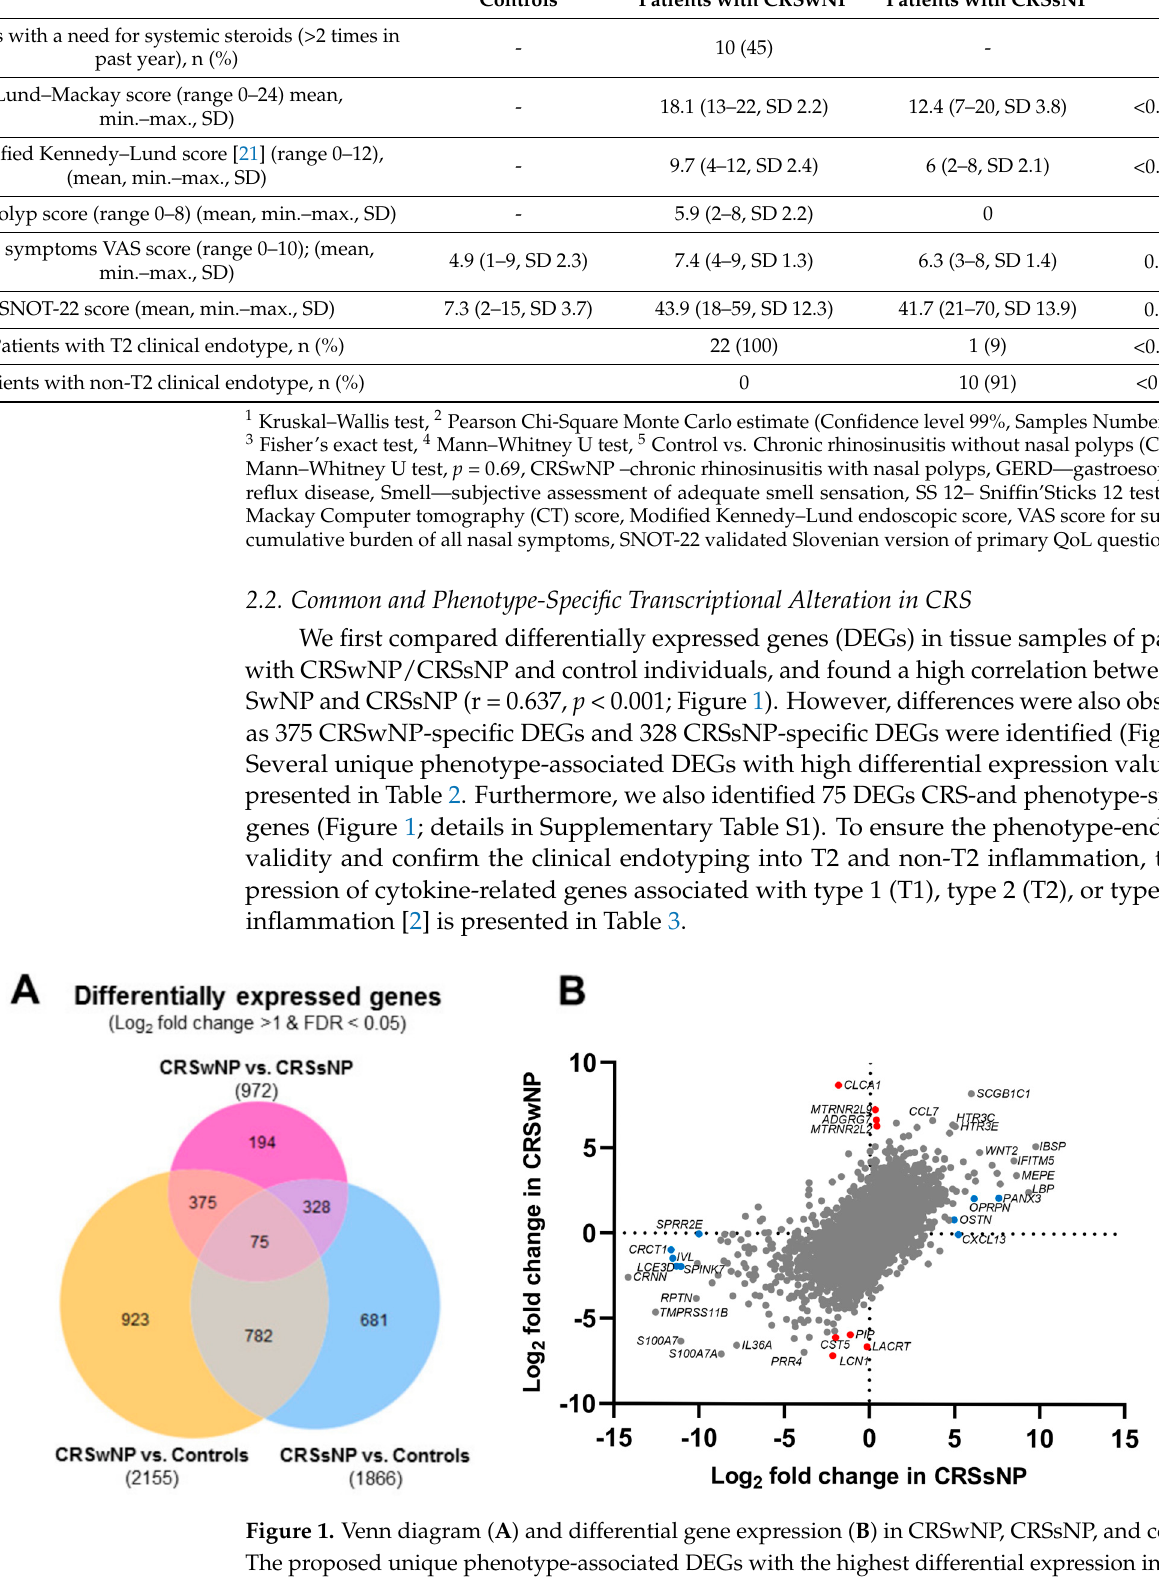
Table 1. Cont. Controls Patients with CRSwNP